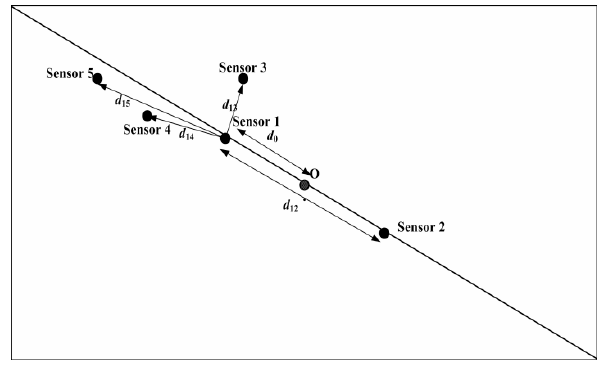
Figure 8. The distribution map of five sensors.